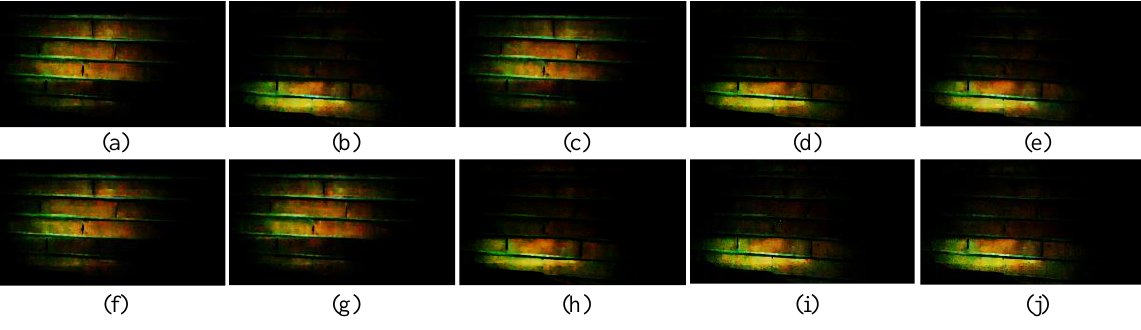
Figure 9. Ten consecutive video frames recorded during the evaluation of the prototype. For the ease of understanding, the chronological order of the frames was marked with letters from ( a – j ).